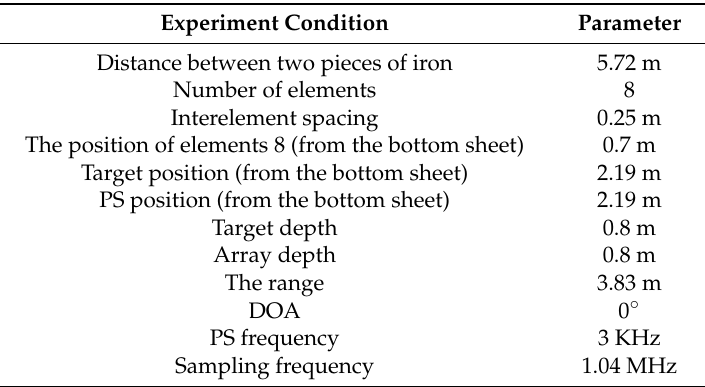
Table 5. Experiment environment.